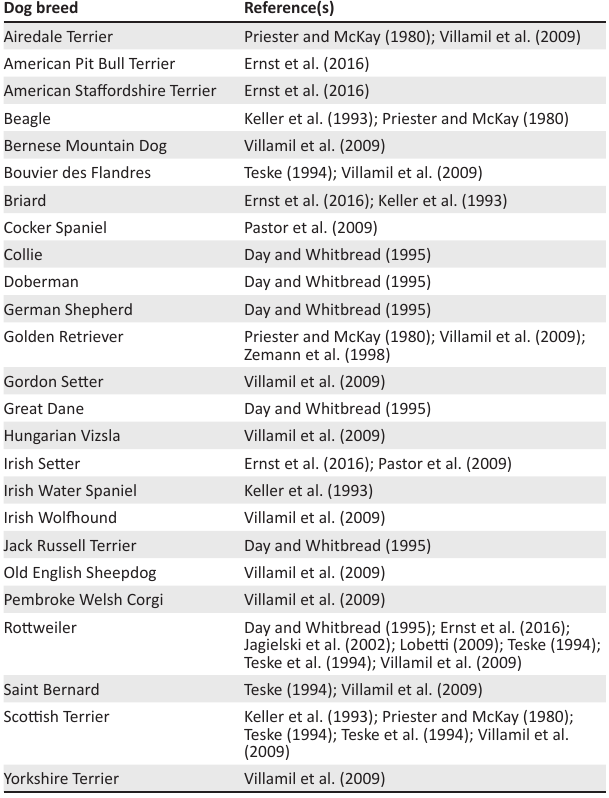
TABLE 4: List of dog breeds that have been previously described in the veterinary literature as being overrepresented in lymphoma populations compared to their reference